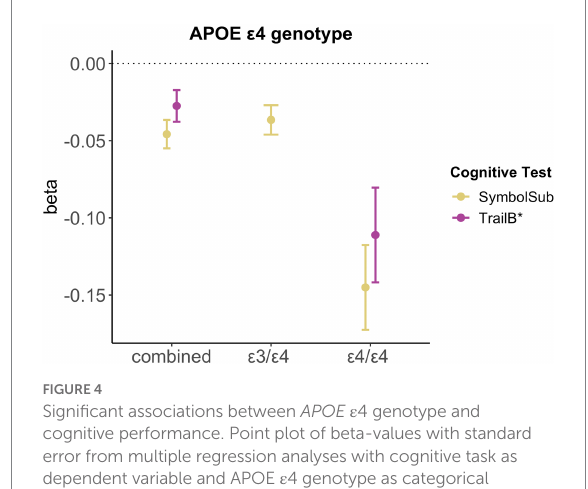
FIGURE 4 Significant associations between APOE ε 4 genotype and cognitive performance. Point plot of beta-values with standard error from multiple regression analyses with cognitive task as dependent variable and APOE ε 4 genotype as categorical independent variable. All models are adjusted for age, education, body mass index, Townsend deprivation score, and lifestyle score. All variables were standardized prior to performing the multiple linear regression analysis (subtracting the mean and dividing by the standard deviation). For visualization purposes, cognitive tests marked with * are inverted (multiplied by − 1). Sample size for Symbol Substitution (non-carrier = 34,266, carrier one e4 allele = 11,023, carrier two e4 allele = 1,028) and Trail Making B (non-carrier = 29,865, carrier one e4 allele = 9,559, carrier two e4 allele =